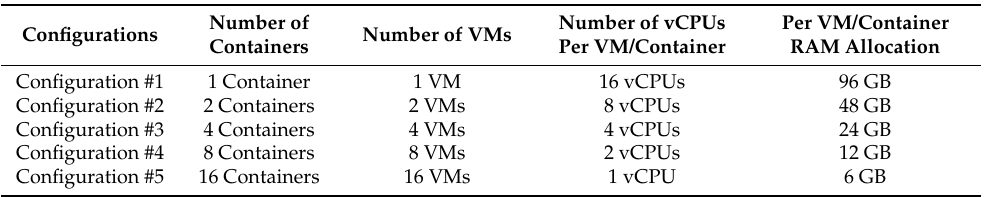
Table 2. Five different configurations of VMs/containers for test-1.